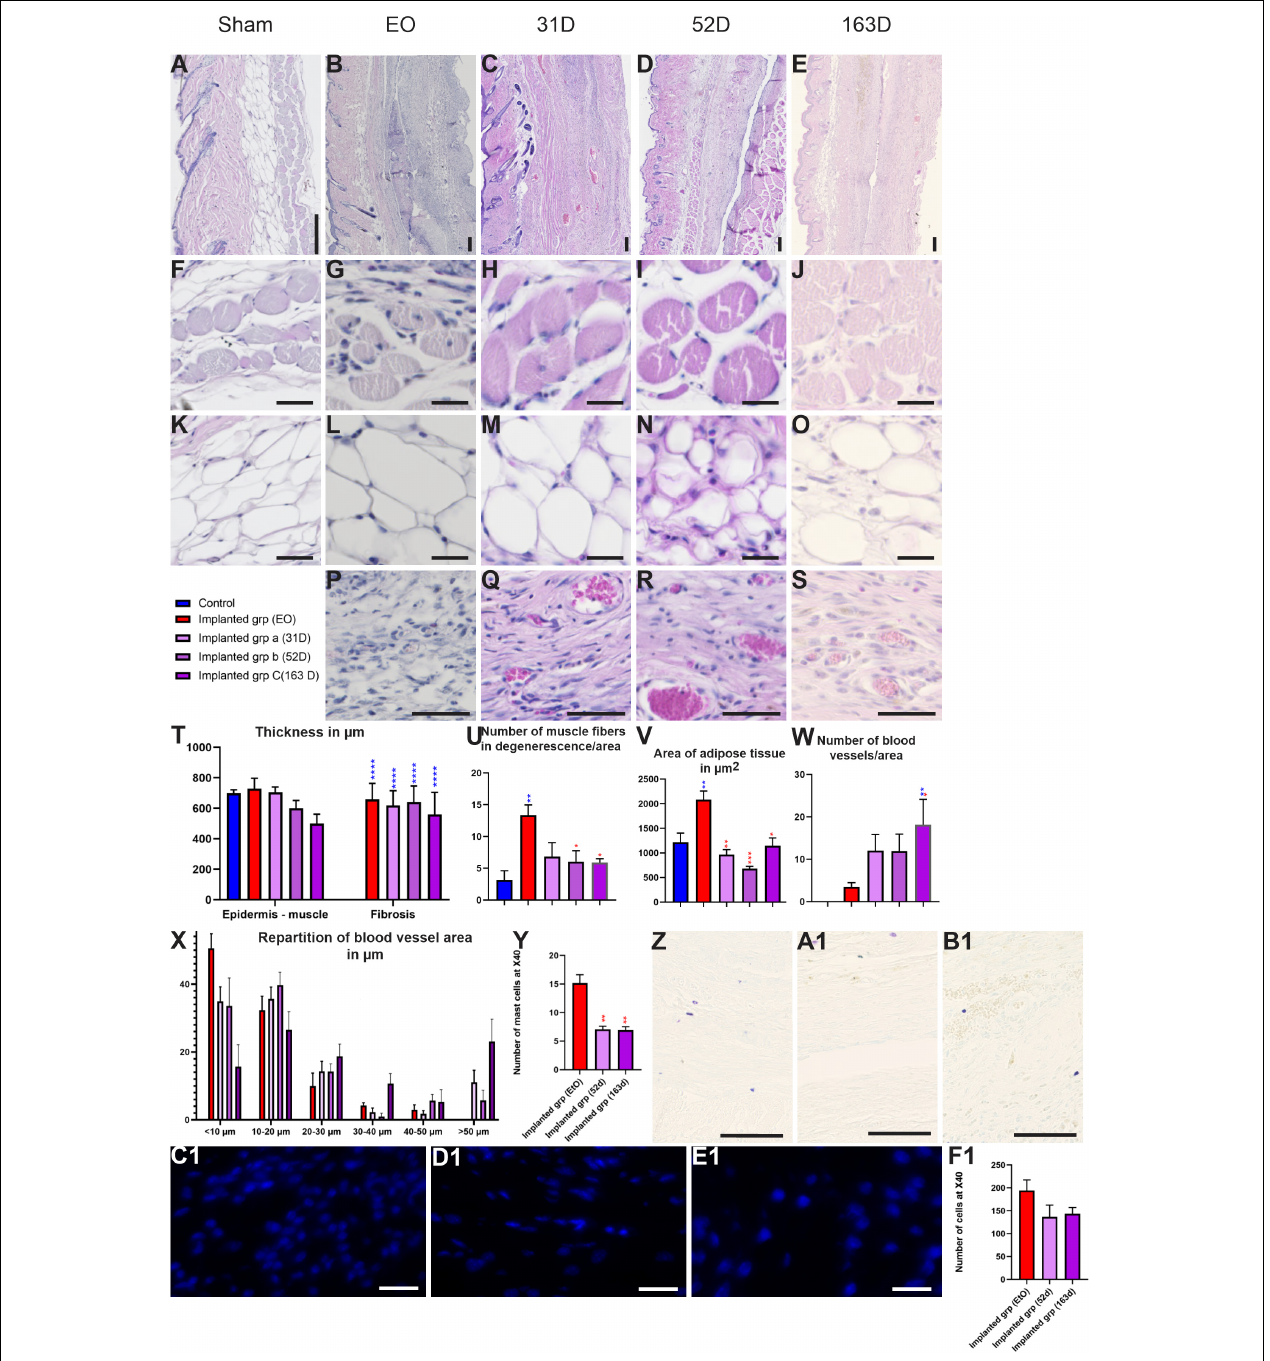
FIGURE 10 | Biocompatibility of devices in implant groups. (A–S) Hematoxylin-eosin staining on skin sections in sham (A,F,K) , EO (B,G,L,P) , 31 days (C,H,M,Q) , 52 days (D,I,N,R) and 163 days (E,J,O,S) groups. (F–J) Magnification of muscular area of skin in groups. (K–O) Magnification of adipose tissue of skin section in different groups. (P–S) Magnification of the neovascularization of the device in EO (P) , 31 days (Q) , 52 days (R) and 163 days (S) implant groups (T) Quantification of thickness between epidermis and muscle and the fibrotic capsule in sham and implanted groups. (U) Muscle fiber degeneration by area. A significant increase in number of muscle fibers in degeneration was observed in EO group in compared to implanted groups. (V) Mean area of adipose tissue in groups. EO group showed a significant increase in adipose tissue area as compared with the implant groups. (W,X) Quantification of angiogenesis after implantation. (Y) Quantification of mast cell density index. Implant groups showed a significant decrease in the number of mast cells as compared with the EO group. (Z,B1) Toluidine blue sections show mast cells in EO (Z) , 52 days (A1) and 163 days (B1) groups. (C1–F1) Representative DAPI-stained section of the implant demonstrating cellularity in EO (C1) , 52 days (D1) and 163 days (E1) groups. (F1) Quantification of DAPI-stained sections. Groups show no significant difference. Scale bar = 200 µ m. One-way ANOVA and Turkey’s test * p < 0.05; ** p < 0.01; *** p < 0.001 and **** p <